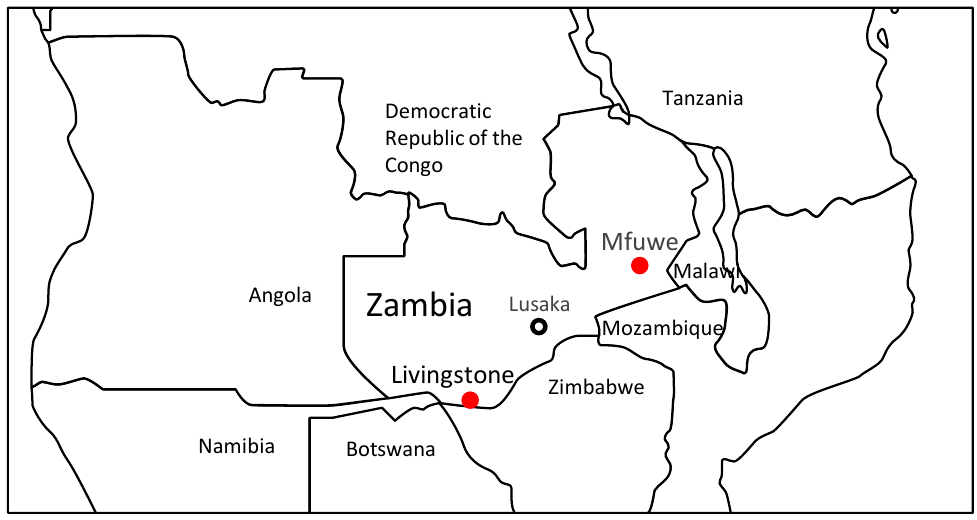
Figure 1. Map of Zambia showing the location of the sampling sites (Mfuwe and Livingstone).